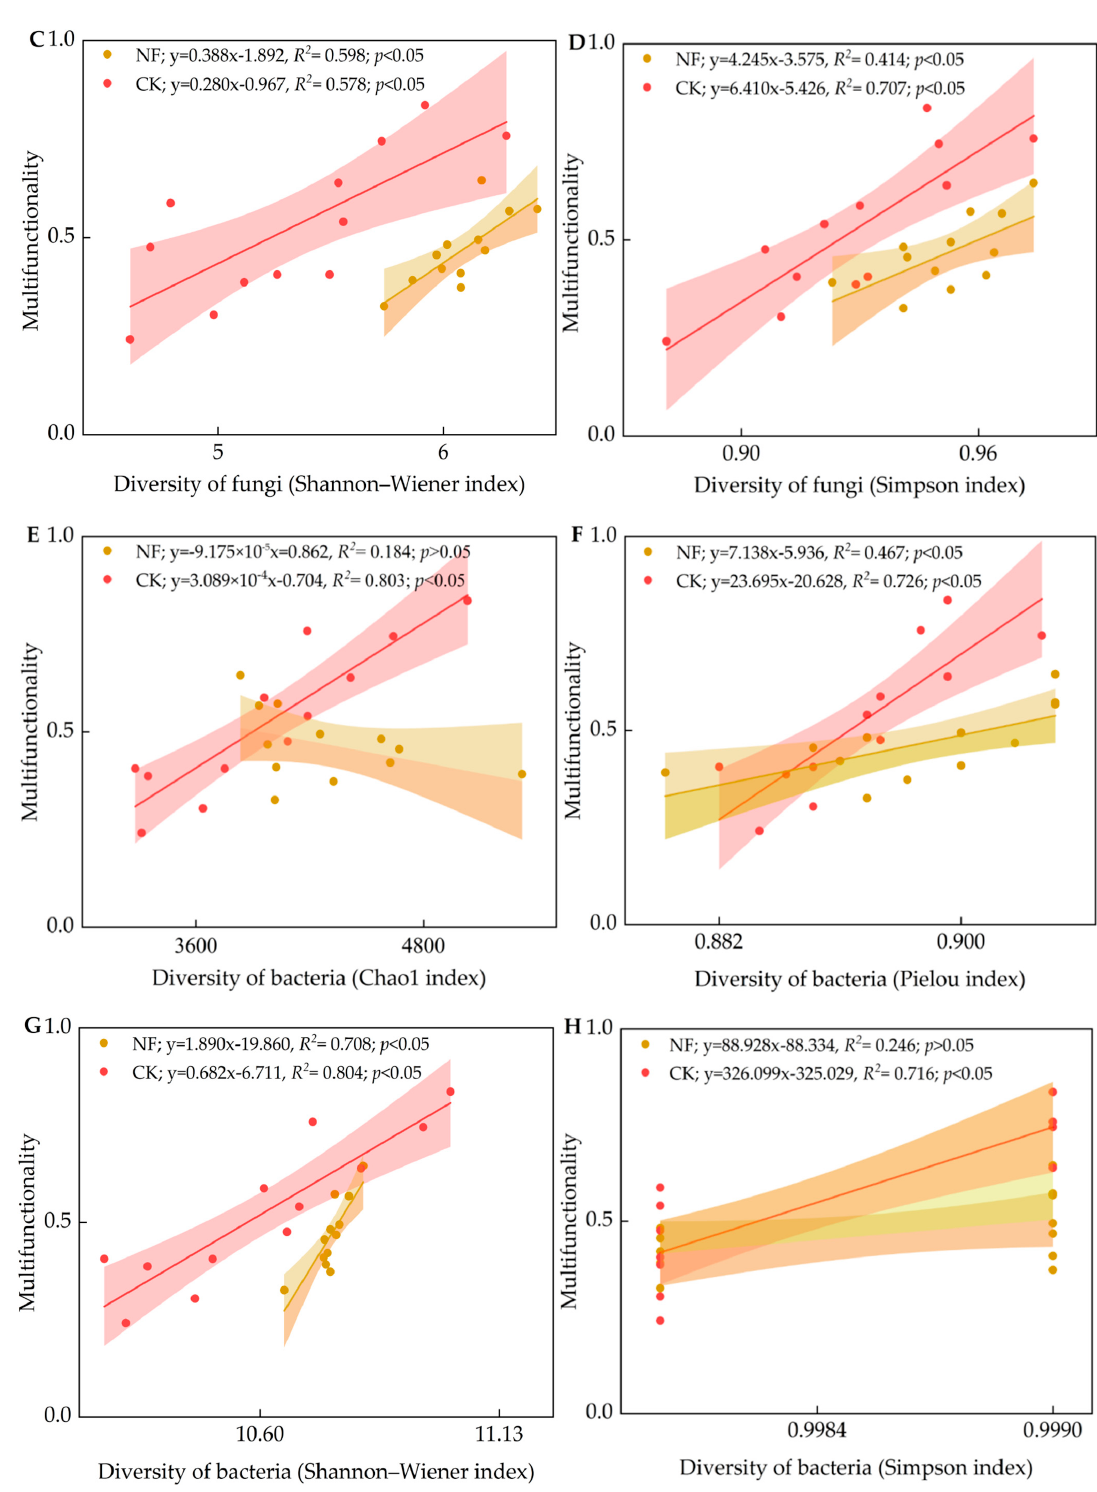
Figure 6. The relationship between microbial diversity and ecosystem multifunctionality. Yellow and red colored dots indicate NF and CK, respectively. The translucent areas indicate 95% confidence intervals. ( A ), Chao1 index of fungal diversity; ( B ), Pielou index of fungal diversity; ( C ), Shannon–Wiener index of fungal diversity; ( D ), Simpson index of fungal diversity; ( E ), Chao1 index of bacteria diversity; ( F ), Pielou index of bacteria diversity; ( G ), Shannon–Wiener index of bacteria diversity; ( H ), Simpson index of bacteria diversity.